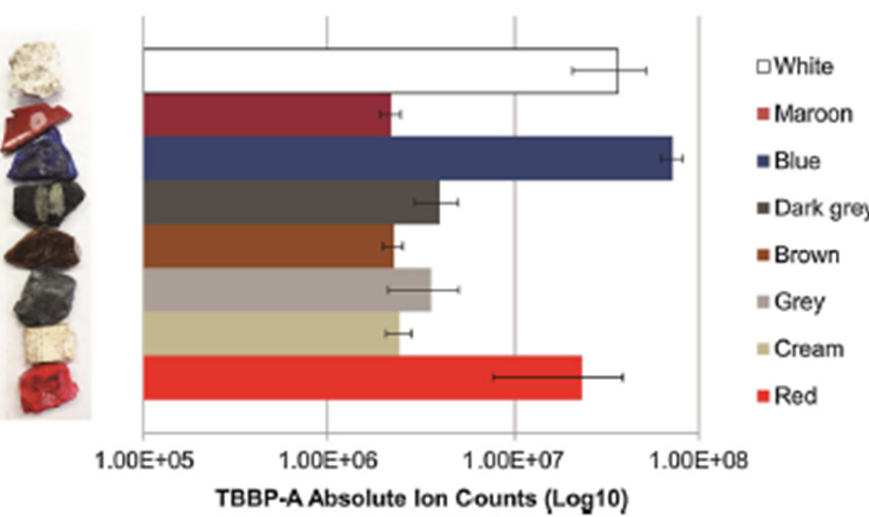
Figure 9. Histogram of the intensities obtained after the analyses of plastic e-wastes as a function of their color. The intensity of the ion m / z 542.8 corresponding to tetrabromobisphenol A (TBBP-A) was based on three replicate measurements. (Reprinted from [32] with permission of John Wiley and Sons.)